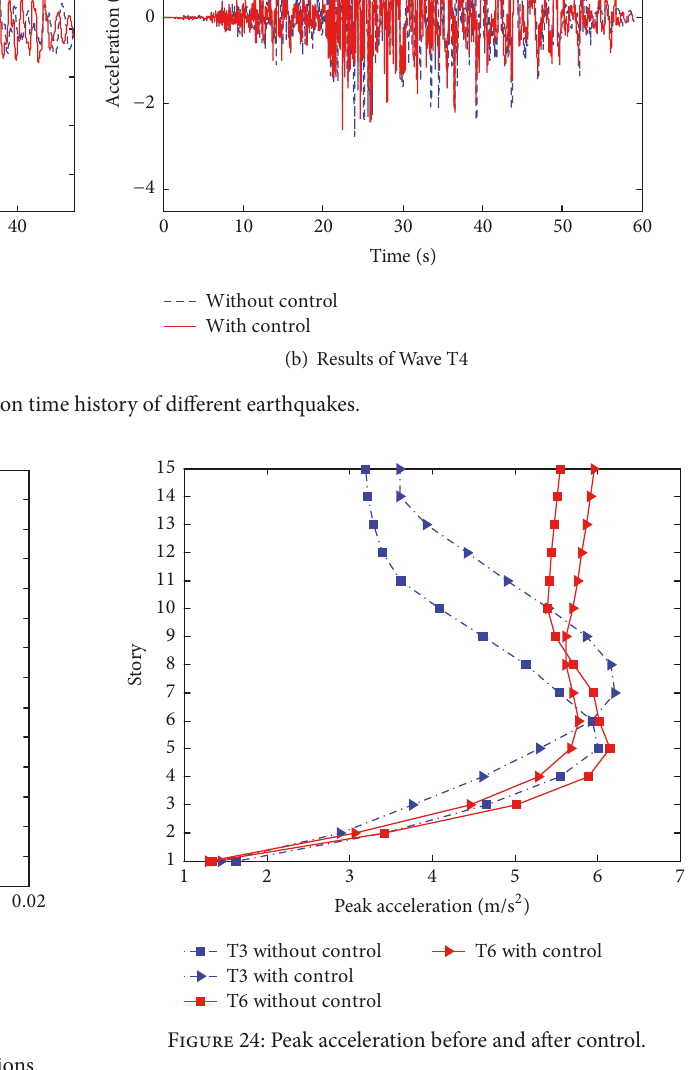
Figure 23: Interstory drift angle for different ground motions.